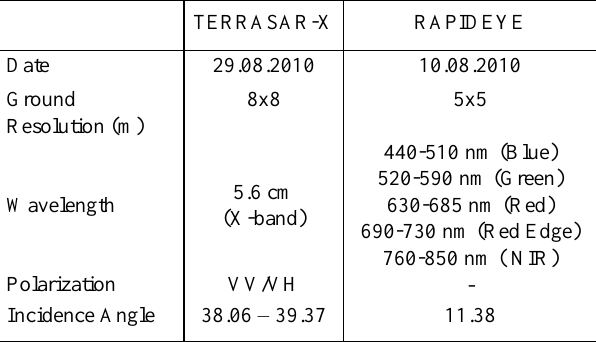
Table 1. Specifications of